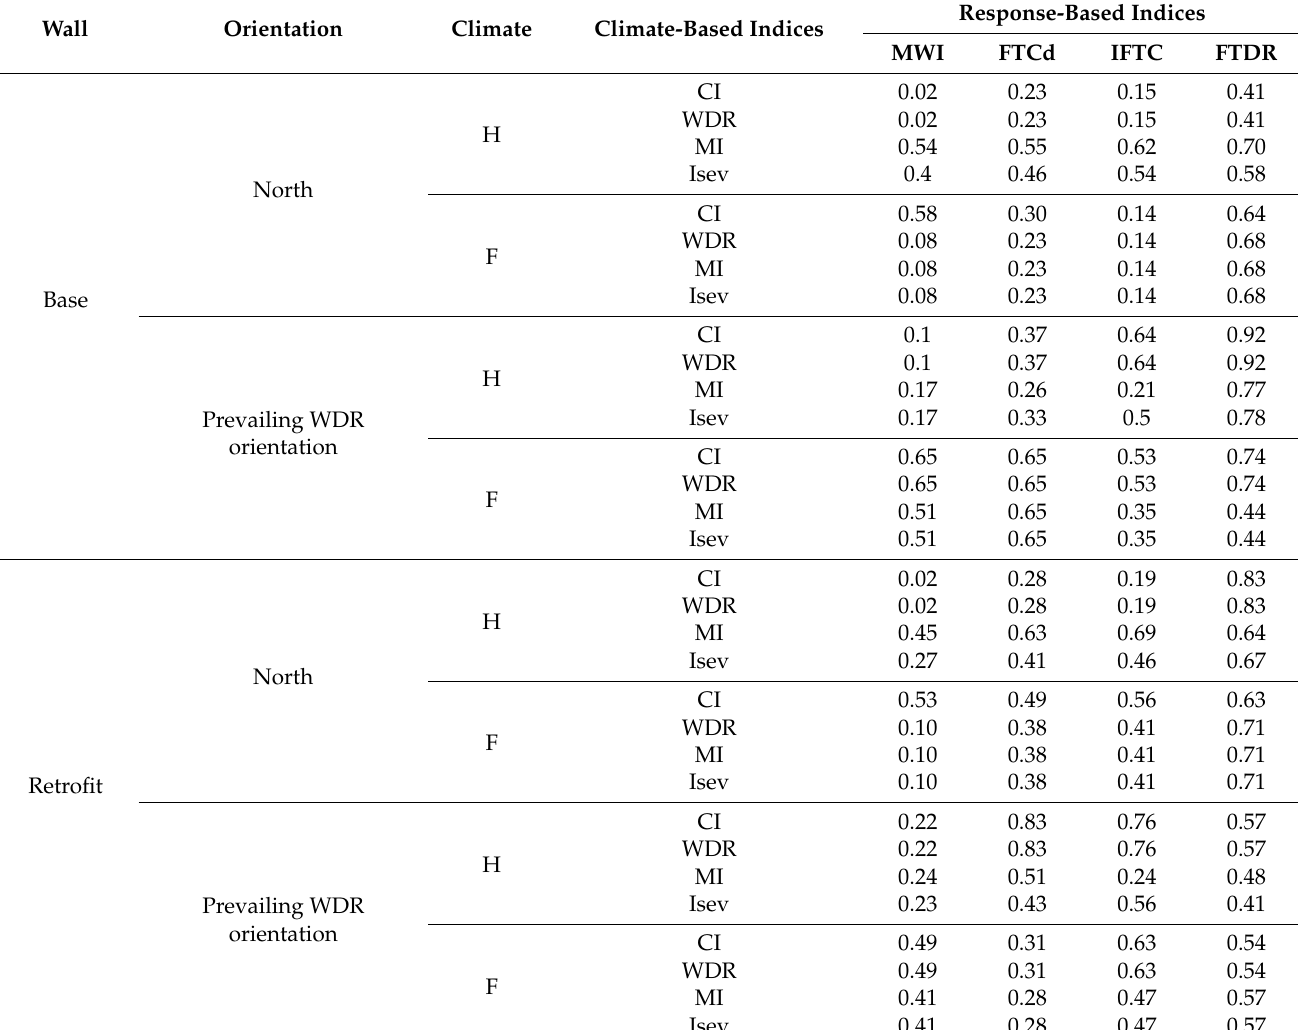
Table 5. Ratio of the average normalized values of the top three years ranked based on the climate-based indices and simulated results for